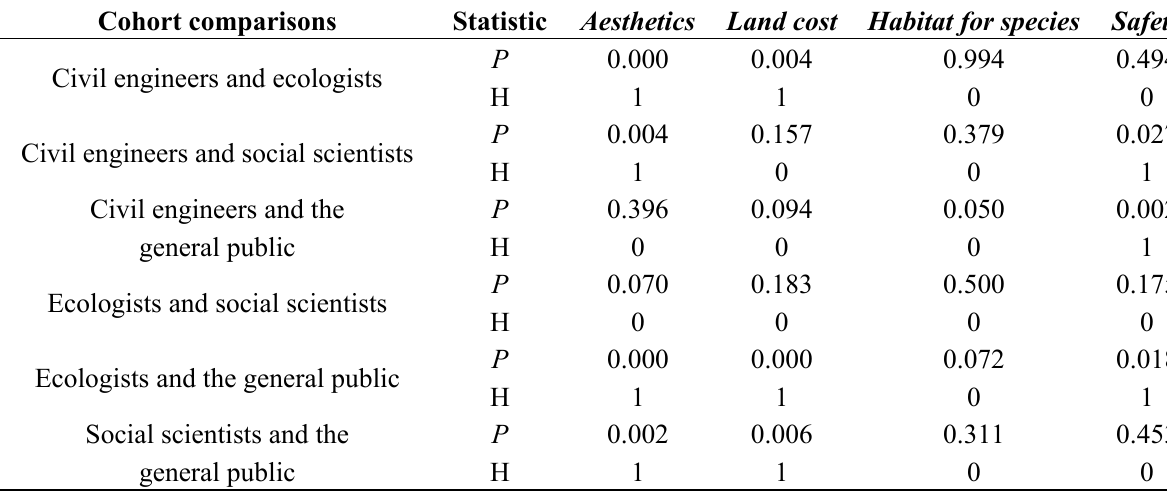
Table 7. Assessment of the statistically significant differences between different cohorts of estimators (civil engineering, ecology and social science students, and the general public) for selected SuDS characterization variables ( aesthetics , land cost , habitat for species and safety ) using the non-parametric Mann-Whitney U-test (see also Section